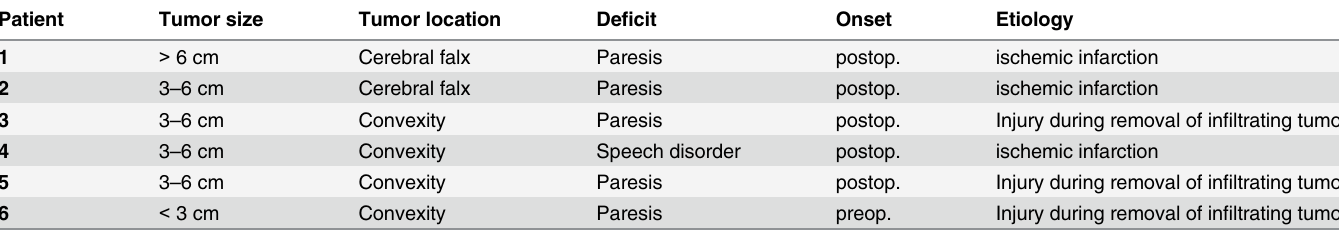
Table 4. Characteristics of patients suffering deficits at